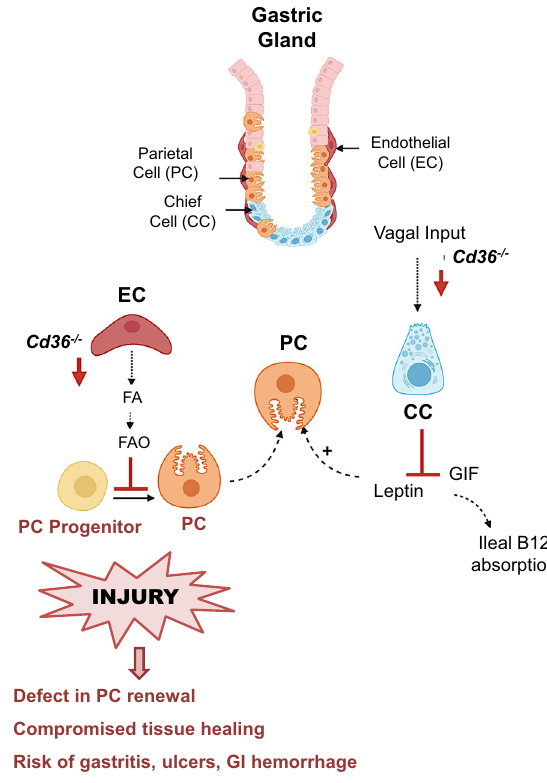
Fig. 9 CD36 regulates stomach function and tissue renewal postinjury. CD36 is abundant in corpus endothelial cells (EC) and expressed in parietal cells (PC). It is not detected in chief cells (CC), but its de fi ciency through vagal input and likely muscarinic receptor 1, suppresses CC release of leptin and gastric intrinsic factor (GIF), respectively. GIF is necessary for ileal vitamin B12 absorption. CD36 deletion reduces endothelial delivery of fatty acids to the corpus, tissue energy stores and mitochondrial FA oxidation, critical for stem cell functionality. Impaired renewal of the CD36 -/- gastric epithelium re fl ects defective PC progenitor differentiation to PCs and not progenitor proliferation or dysfunction of mature PCs. Low gastric leptin secretion could further impair tissue healing. The reduced tissue ability for adequate repair would contribute to the etiology of gastric disease, as supported by data from two biomedical databases (see Fig. 8 and Table